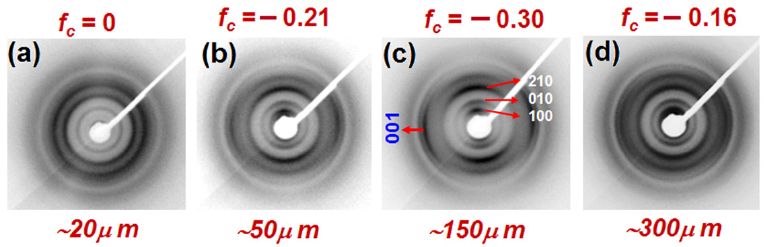
Figure 1. 2D-WAXD EDGE patterns of NC PPO films, as obtained by BE induced crystallization in amorphous films with thickness of: ( a ) ~20 µ m, ( b ) ~50 µ m, ( c ) ~150 µ m and ( d ) ~300 µ m, after guest extraction. Degree of orientation ( f c ) is indicated at top of the patterns. The 001 reflection arc (centered on the equator) and the main hk0 reflection arcs (centered on the meridian), which show the occurrence of c ⊥ orientation, are indicated in the pattern ( c ).